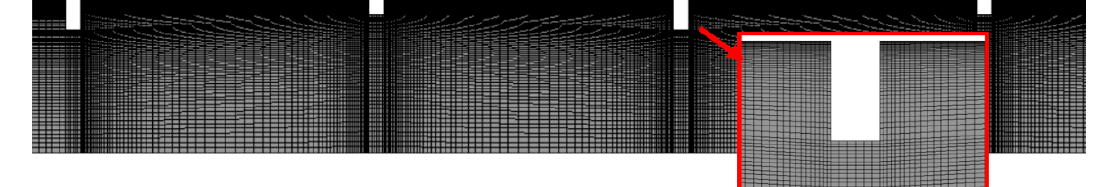
Figure 3. Partial view of the computational grid, with 87,271 nodes.